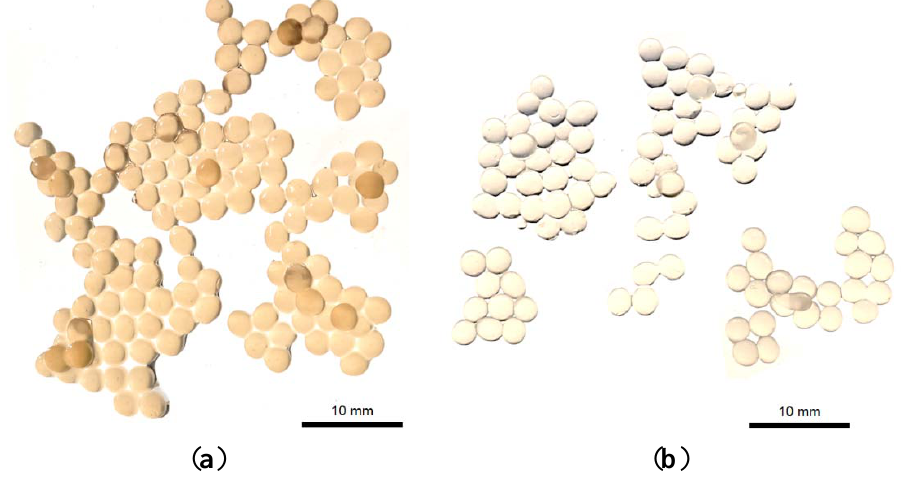
Figure 3. Digital images of ( a ) the herbal extract-loaded calcium alginate beads and ( b ) the empty calcium alginate